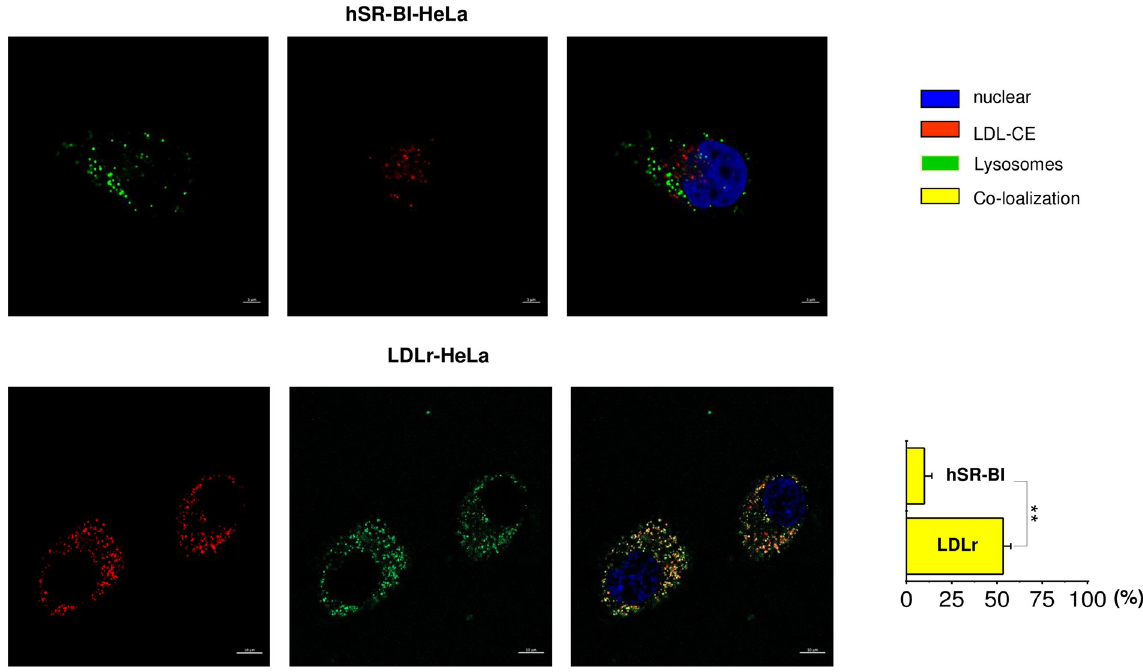
Fig 5. Transport of CE-LDL to the lysosomal compartment in various HeLa cells. HeLa cells were plated at 30% confluency on glass covered slips and then pre-incubated in serum free media for 24 hours prior to experiments. Labelled CE-LDL were added to the media for 1 hour, washed and chased for 30–60 minutes in serum/lipoprotein free media. In the presence of Lysotracker Green (lysosomal marker). The data is arranged in rows with a color code seen on the right side of the panels. The confocal images of CE labeled LDL internalization to lysosomes utilizing Lysotracker green are shown for mock, SR-BI and LDLr HeLa cells as indicated at the top of the panels. The bar corresponds to 10 μ m, � p < 0.015, �� p < 0.01.